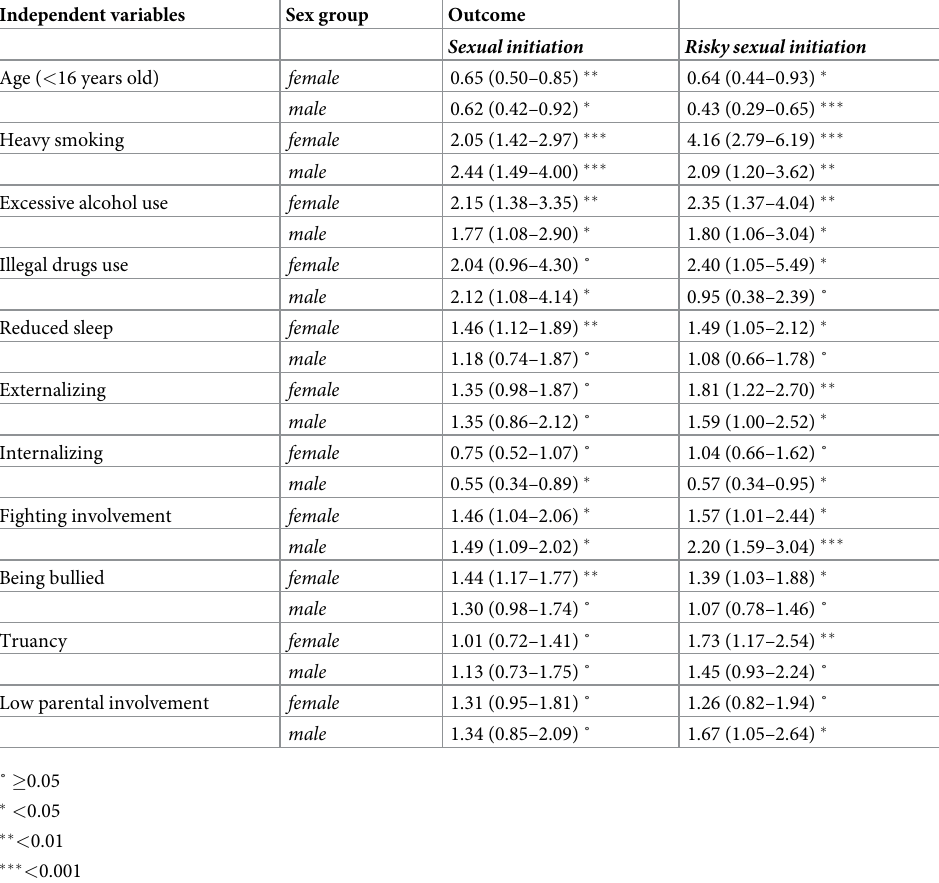
Multivariable multinomial logistic regression derived odds ratios (and 95% confidence intervals). The dependent variable (reference category “no sexual initiation”) was categorized depending on the absence (Sexual initiation) or presence (Risky sexual initiation) of reproductive risk factors (multiple partners or infrequent condom use). Only predictors showing significant association in at least one stratum were kept in the multivariable